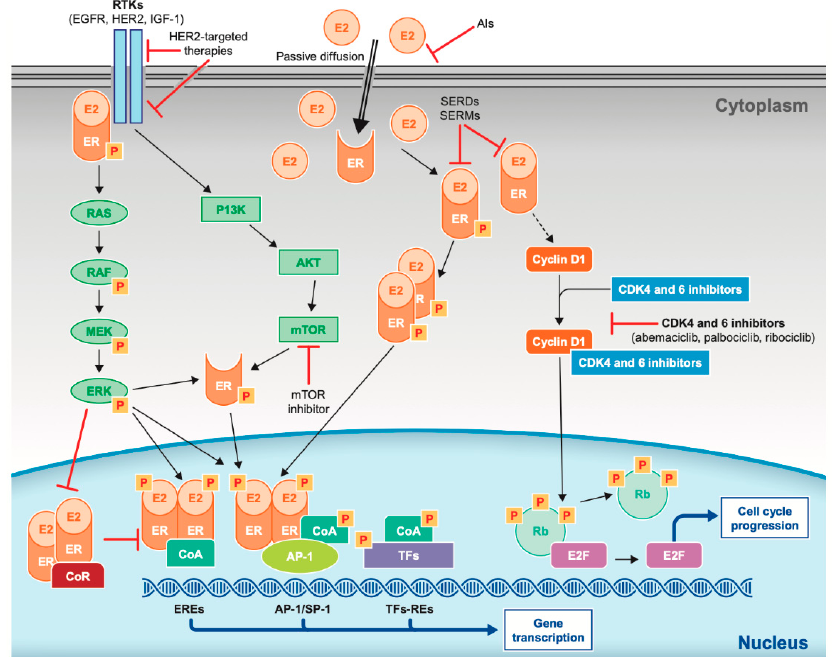
Figure 1. Receptor pathways involved in the progression of breast cancer and mechanism of action of endocrine and targeted therapies. AI = aromatase inhibitor; AKT = protein kinase B; CDK = cyclin- dependent kinase; CoA = coactivator complex; CoR = corepressor complex; E2 = estradiol; EGFR = epidermal growth factor receptor; ER = estrogen receptor; ER = estrogen receptor; EREs =